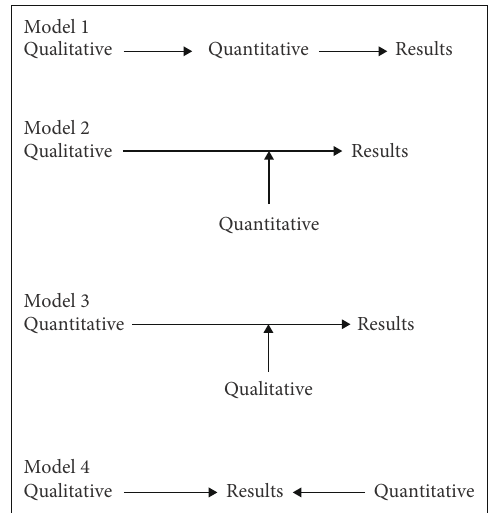
Figure 2: Mixed research